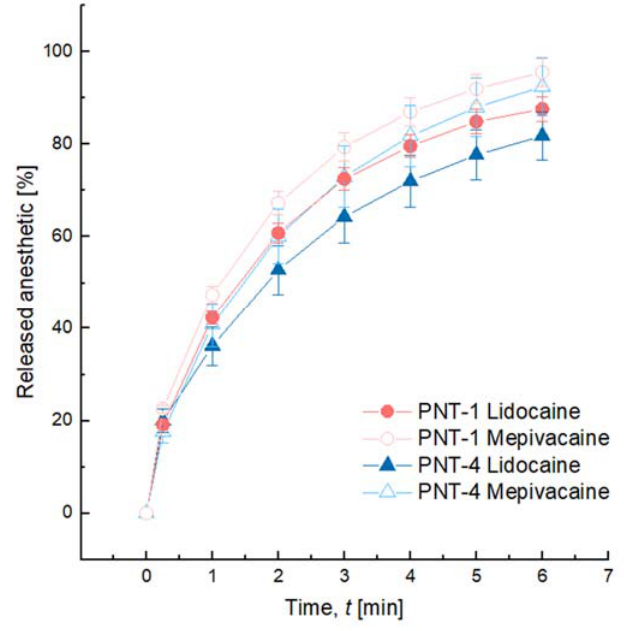
Figure 2. Release profiles of lidocaine and mepivacaine from PNT-1 and PNT-4. For each time point, and for each formulation, 3 gels were evaluated. Results are expressed as means ± SD.